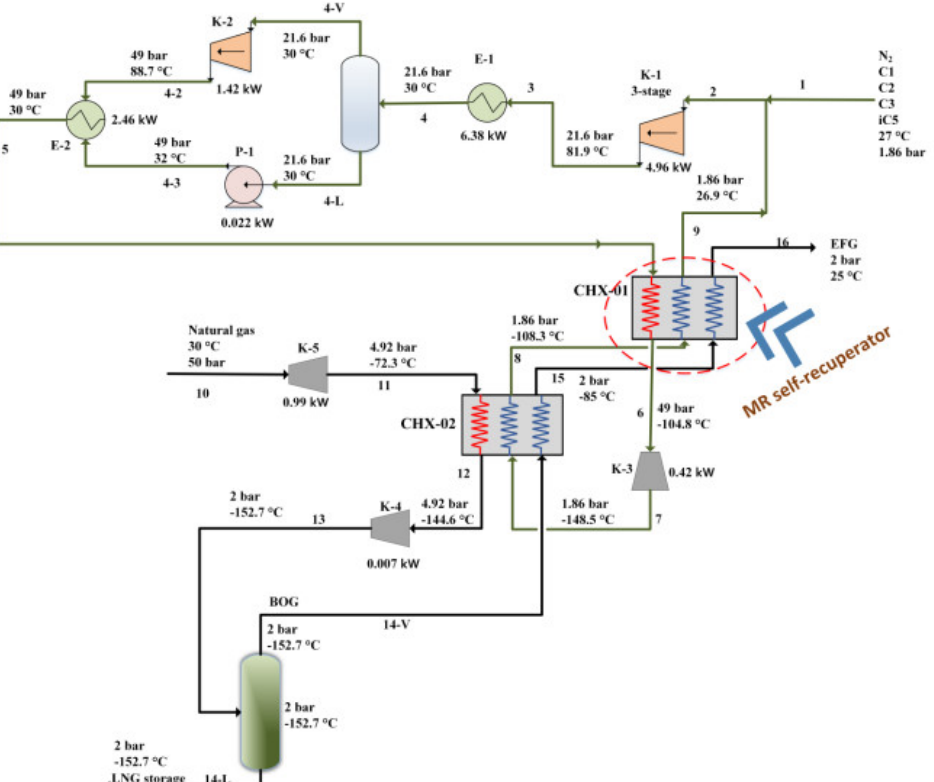
Figure 34. SMR process optimized by Qyyum et al. [127]. Reproduced with permission from Energy Proceedings.